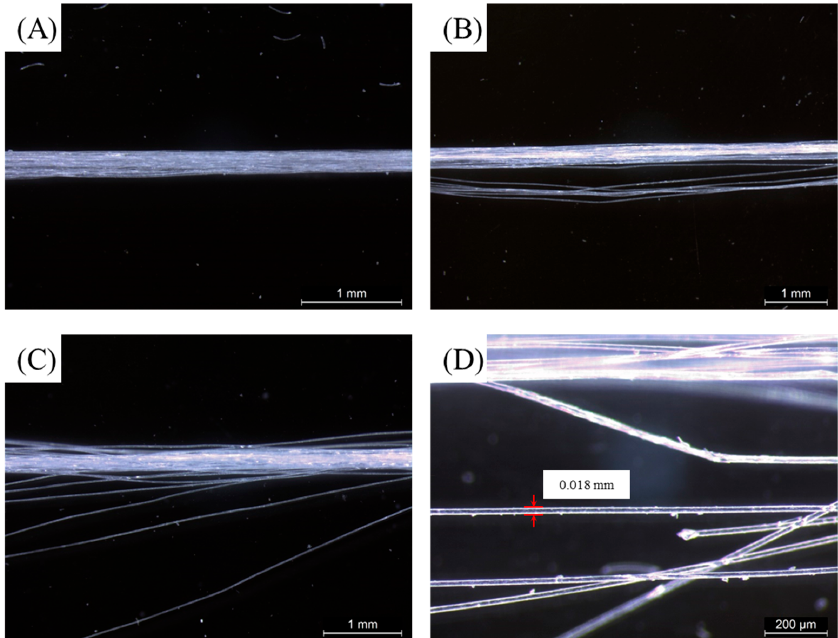
Figure 8. Typical microscopic images of ( A ) the initial PLA/PHB yarns and the PLA/PHB yarns after ( B ) two weeks, ( C ) four weeks, and ( D ) eight weeks immersed in both UV lighting and aerated seawater.